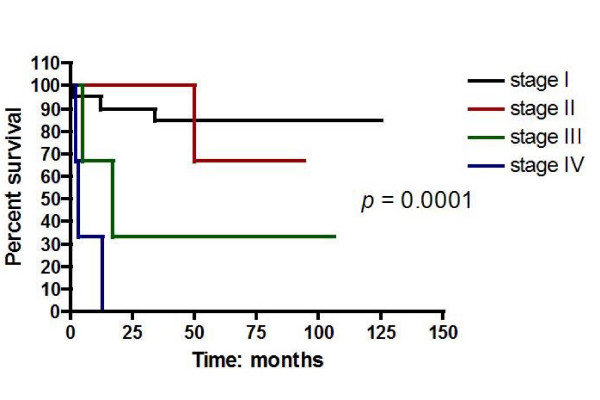
Disease specific survival rate according to tumoral stage. The advanced stages showed poorer survival (p < 0.05).